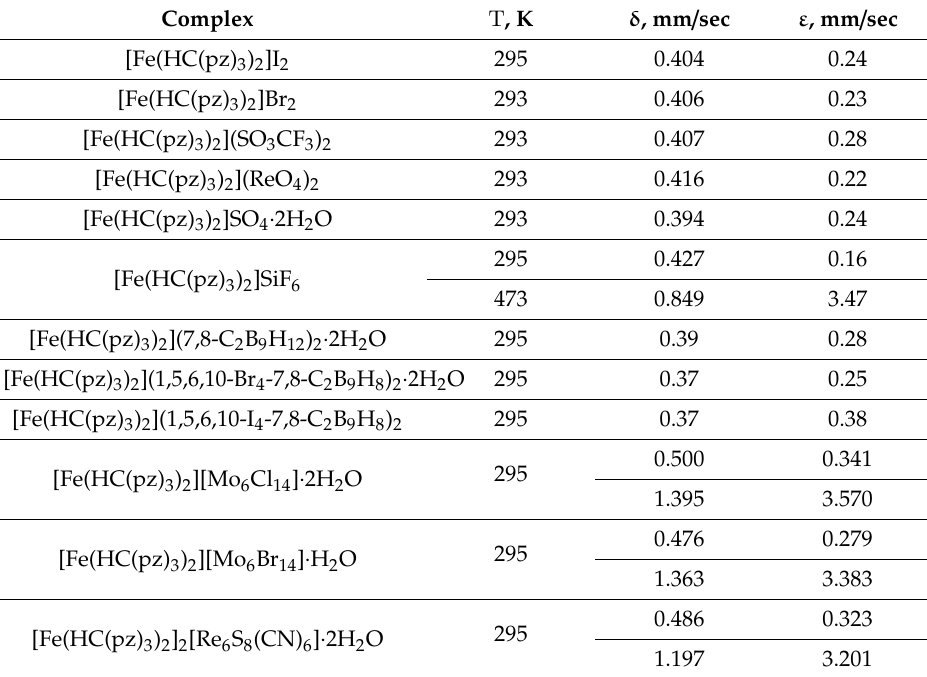
Table 5. Basic Mössbauer parameters of the iron(II) complexes.